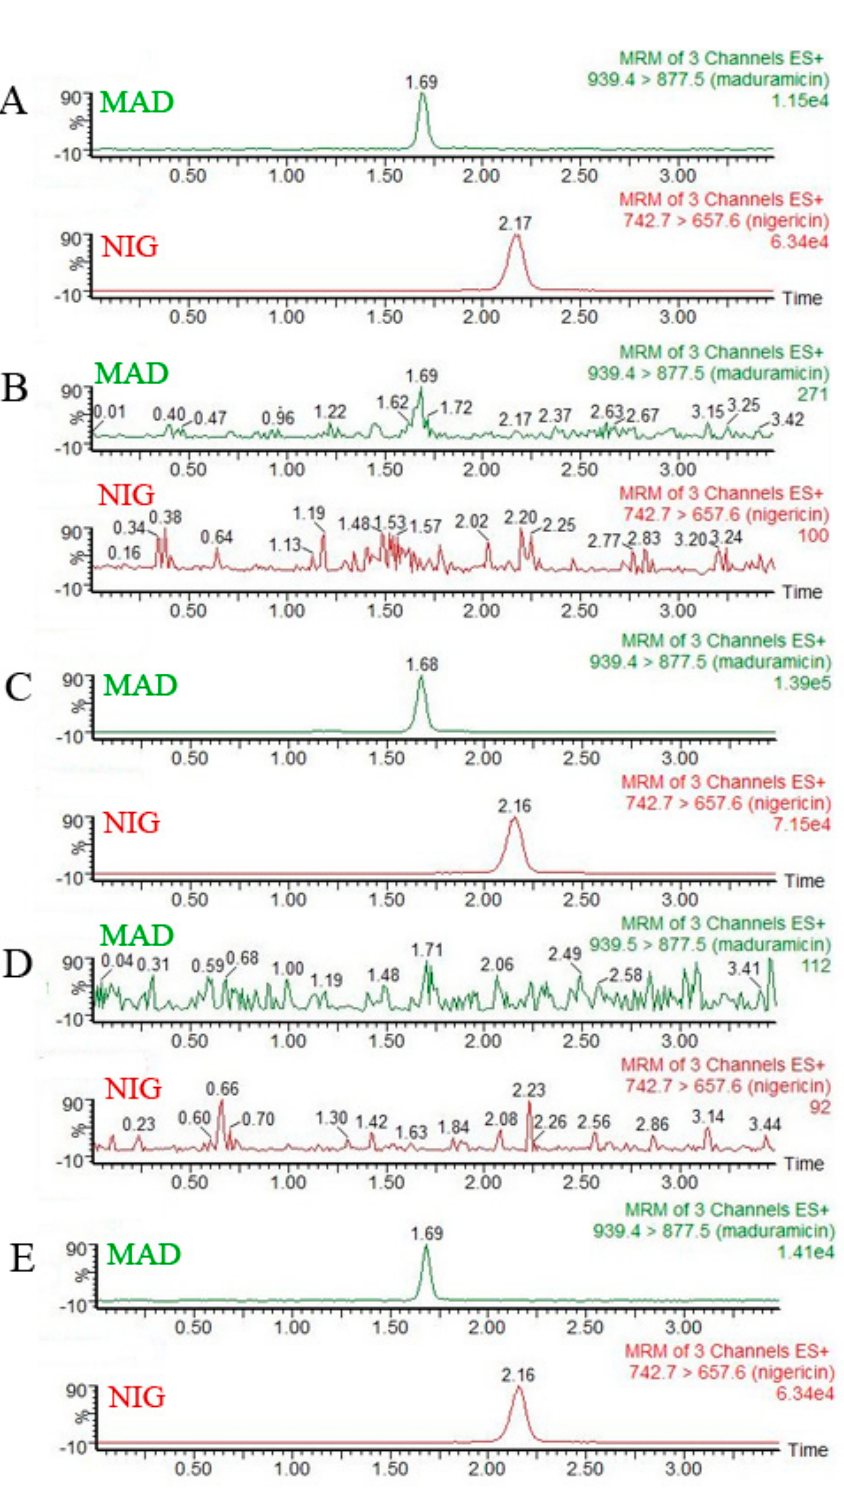
Figure 2. Mass chromatograms of standard maduramicin (MAD) and nigericin (NIG) solutions, blank tissues, and blank tissues spiked with MAD and NIG. Quantitative ion mass spectra of MAD and NIG: ( A ) 1 ng · mL − 1 standard MAD solution; 20 ng · mL − 1 standard NIG solution. ( B ) Blank hepatopancreas tissues of crayfish. ( C ) 20 µ g · kg − 1 MAD and 400 µ g · kg − 1 NIG spiked in the hepatopancreas of crayfish. ( D ) Blank abdominal muscle of crayfish. ( E ) 20 µ g · kg − 1 MAD and 400 µ g · kg − 1 NIG spiked in the abdominal muscle of crayfish.